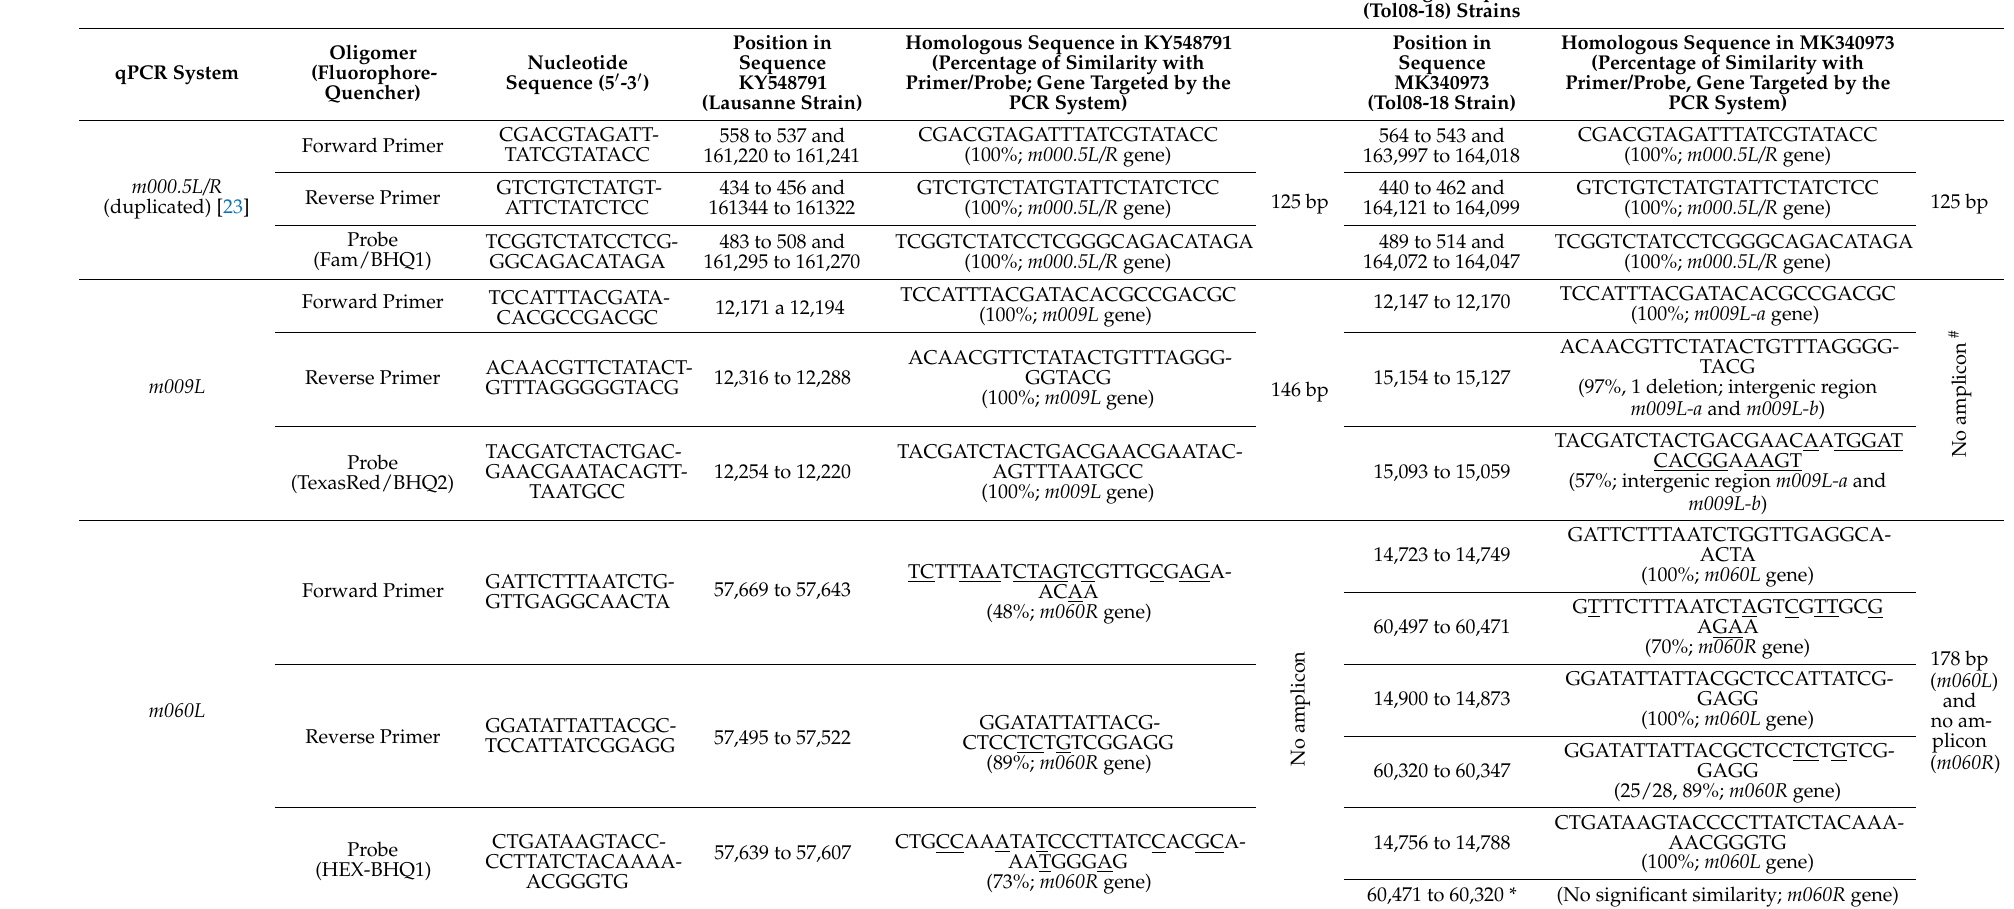
Table 2. Genomic location of the targets and sequences of the primers and probes used in the mPCR. Homology against two standard sequences (Lausanne strain (KY548791), and Tol08-18 strain (MK340973)) is marked. Underlined nucleotides represent mismatches. Location and Conservation of the Primers and Probes’ Target Sequences in the Classic MYXV (Lausanne) and ha-MYXV (Tol08-18)